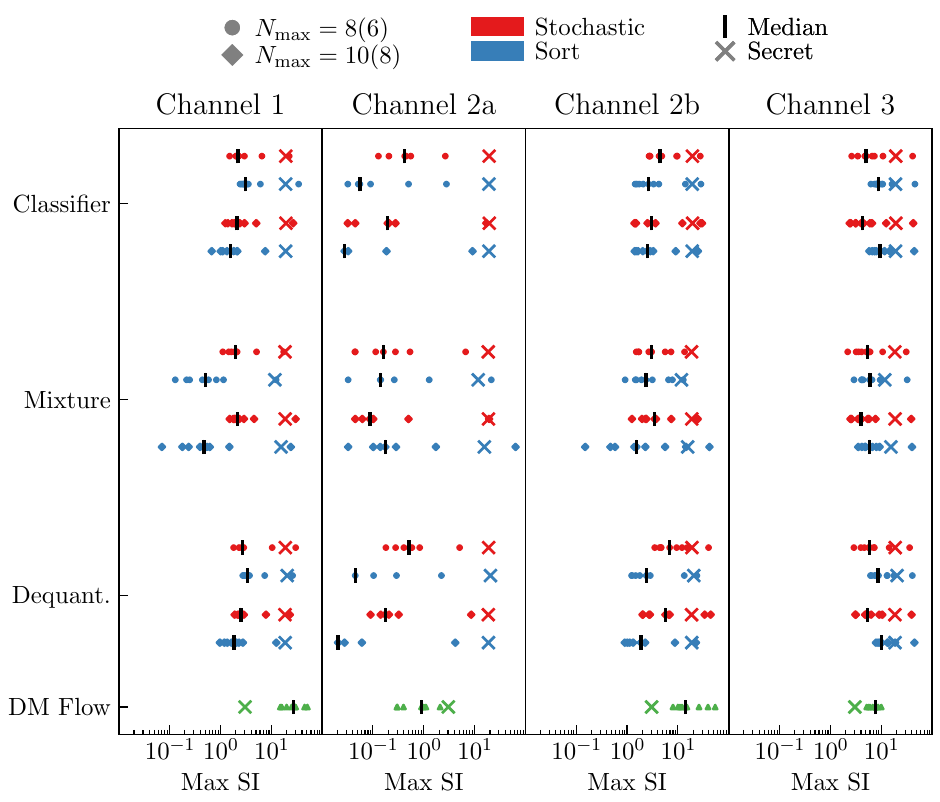
Figure 15: Max SI scores (eq. (25)) for the three models listed in section 4.2, eval- uated with stochastic permutation (red) and sort surjection (blue) and varying N indicated by the marker shapes. The results of the flow model used in [ 21 ] are shown in green diamonds. The black bar indicates the median performance of the BSM sig- nals. The performance on the secret dataset is indicated with a